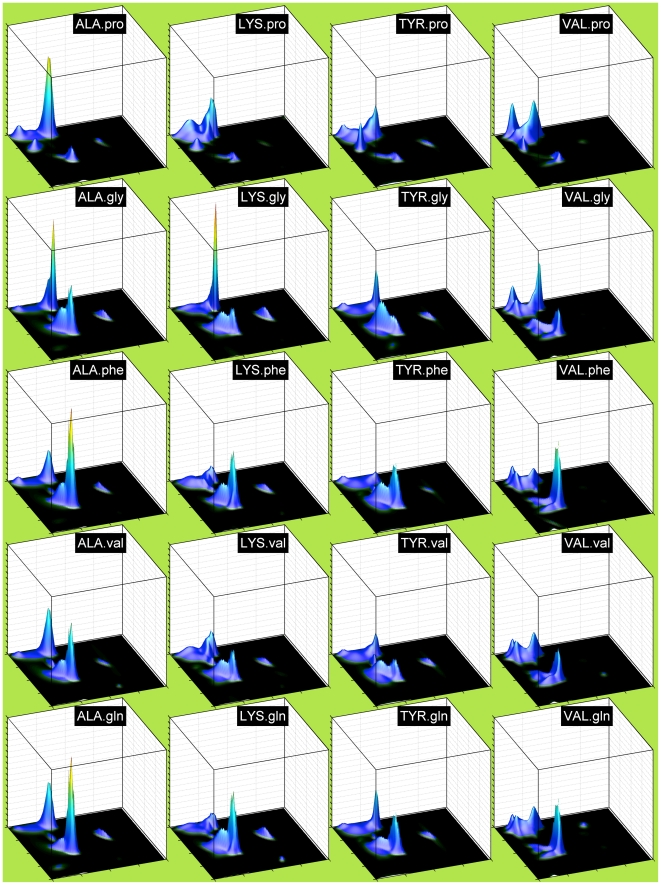
Right Neighbor-dependent Ramachandran distributions of four residues with different right neighbors.Columns (left to right): central residues ALA, LYS, TYR, VAL. Rows (top to bottom): right neighbors pro, gly, val, gln. All plots are scaled to a common maximum probability height.